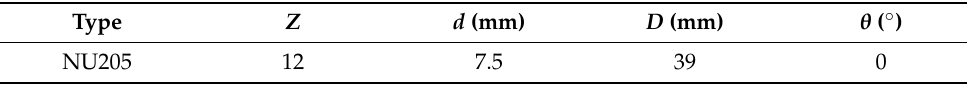
Figure 2. The experiment rig of rolling bearings with compound fault: ( a ) experiment rig; ( b ) data acquisition system. Table 1. The main parameters of rolling bearing.